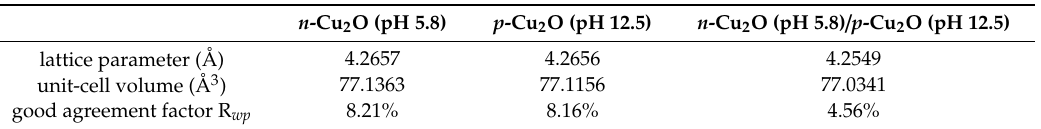
Table 3. Crystallographic parameters of the n -Cu 2 O (pH 5.8), p -Cu 2 O (pH 12.5), and n -Cu 2 O